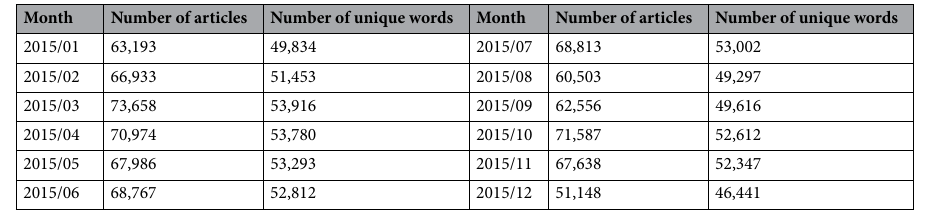
Table 3. Number of articles and unique words in 2015.